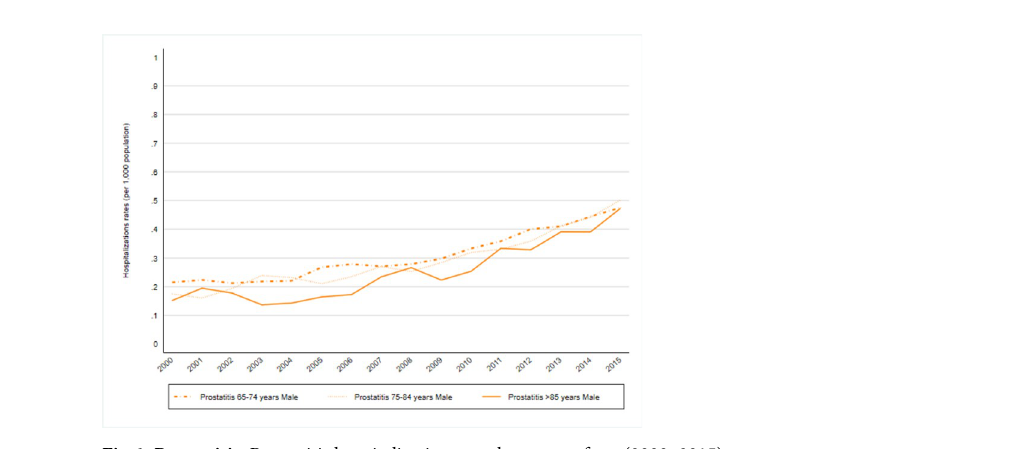
Fig 6. Prostatitis. Prostatitis hospitalization rates by group of age (2000–2015).